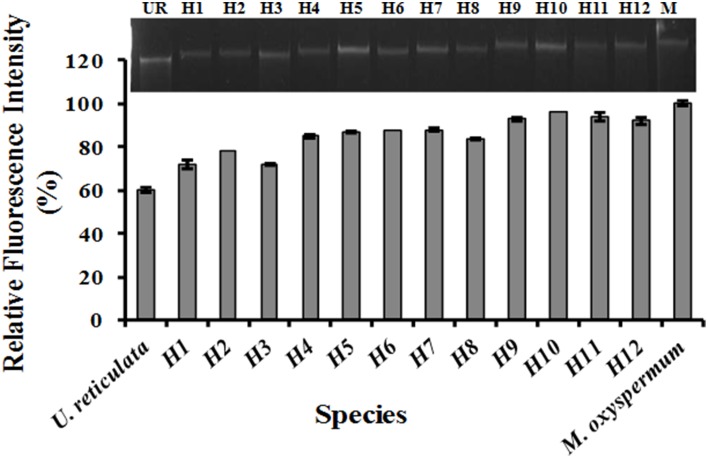
Relative fluorescence intensity of the regenerated hybrids and the fusion partners determined from confocal microscopy. The gel image above the graph showed the migration of total genomic DNA of hybrids and fusion partners. UR, U. reticulata; M, M. oxyspermum; H1–12, Putative hybrids.